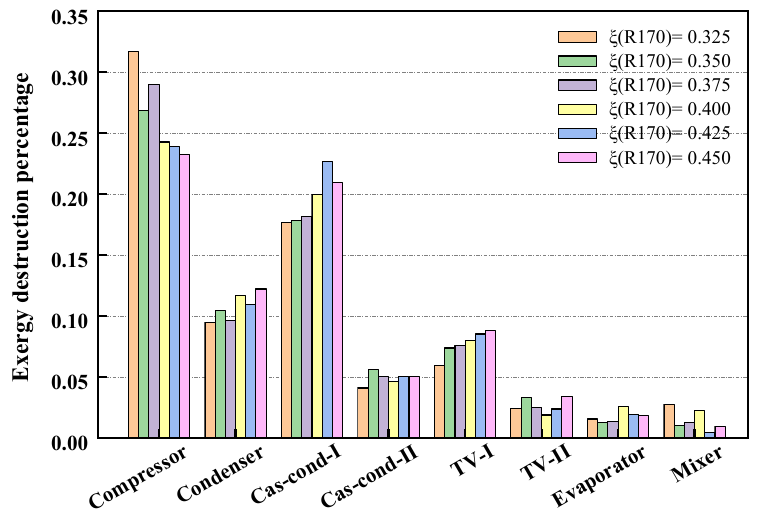
Figure 5. The components’ exergy destruction percentage at different concentrations. The variations in COP, exergy efficiency, and outlet vapor fraction of the evaporator at different concentrations of cryogenic refrigerant are displayed in Figure 6. In the low- temperature process, with increasing the mass fraction of R170 in this MACRC system, the power consumption increases, and the highest efficiency is obtained at the concentration of 0.35. The COP, however, is highest at a concentration of 0.375. The exergy efficiency and COP reduce with increasing the mass fraction of R170 beyond the two highest points. The reason is a higher content of the primary refrigerant increases the power consumption and heat removal of the compressor. Considering the above presentations and combining these two thermodynamic performances, the need for a lower vapor fraction at the evaporator outlet is the best option. A relatively positive thermodynamic performance is presented when the refrigerant R600a/R290/R170 with a mass fraction of 0.25/0.35/0.40. It is known from Table 1 that at this initial refrigerant composition, the suction temperature of the compressor is − 13.1 ◦ C. The higher suction temperature ensures the safe operation of the compressor. Meanwhile, the inlet temperature of the evaporator is − 65.9 ◦ C, which meets the temperature requirements of the ULT. When the compact MACRC system is applied indoors, the ambient temperature is within the range of 20 to 40 ◦ C. We investigated the cycle characteristics under different ambient temperatures when the initial refrigerant composition is the